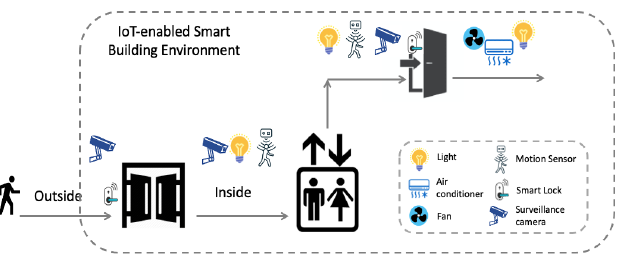
Figure 1. Scenario of user walking outside to inside the smart building with the sensors being